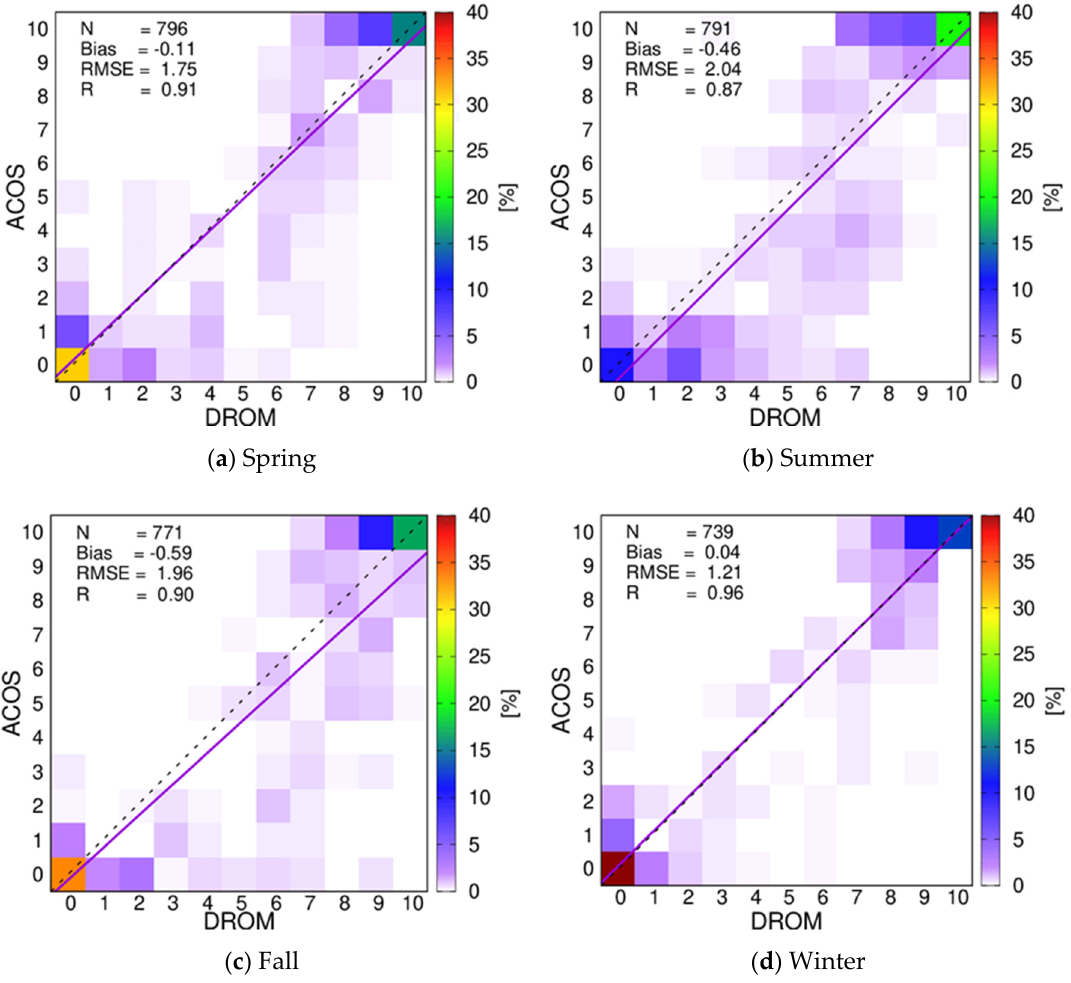
Figure 6. Tenth cloud cover scatterplot of ACOS and DROM for each season (a)–(d) in 2019. The dotted line represents the 1:1 line and the solid line the regression line. N is the number of cases, and R is the correlation coefficient.